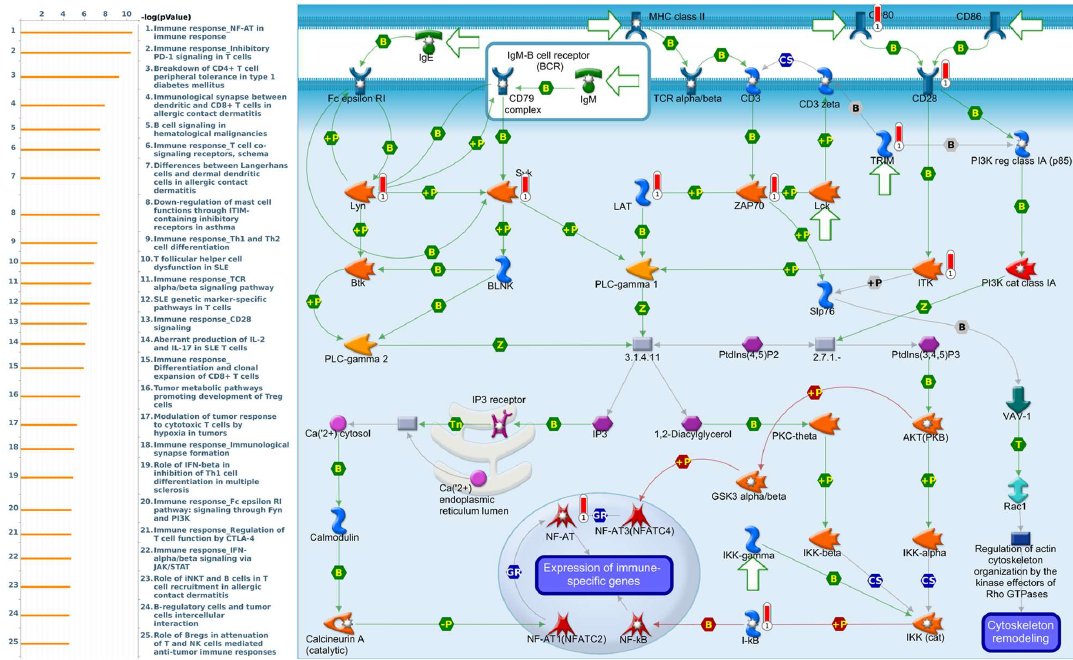
Figure 12. MetaCore pathway analysis of the coexpression gene network of proteasome 20S subunit alpha 8 (PSMA8) in breast cancer patients. We used the MetaCore platform to analyze genes coexpressed with PSMA8 from the associated METABRIC and TCGA datasets, and downstream pathway analyses revealed that “mmune response_NF-AT in immune response” participates in breast cancer development.